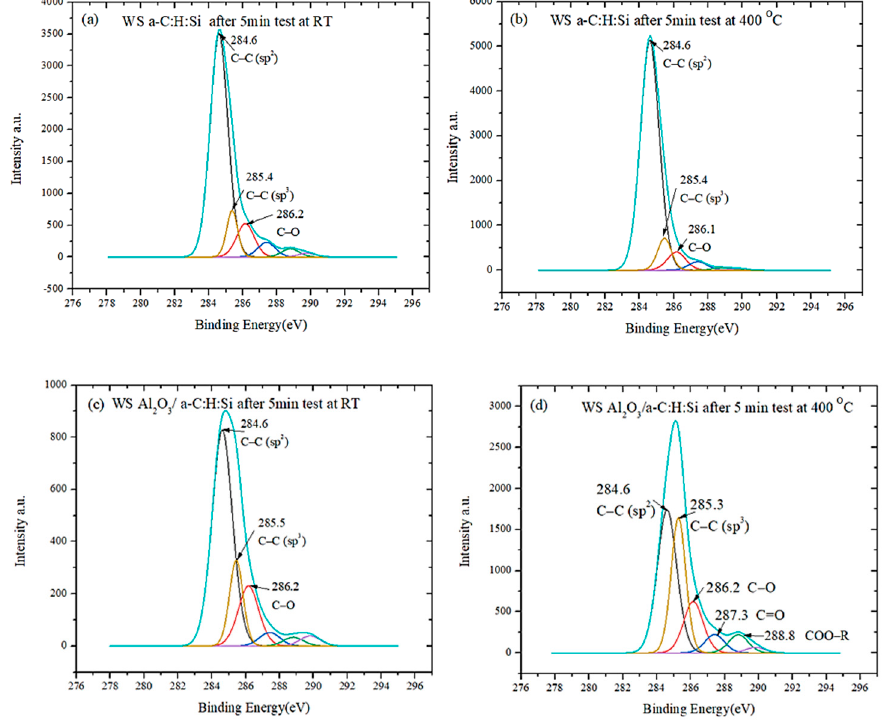
Figure 9. C 1s XPS spectra taken within the wear scars after the 5 min tests at RT and 400 °C on the ( a , b ) a-C:H:Si and ( c , d ) Al 2 O 3 /a-C:H:Si coatings. ( a , b ) a-C:H:Si and ( c , d ) Al 2 O 3 /a-C:H:Si